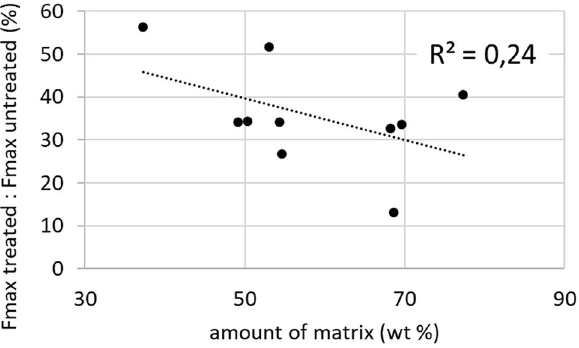
Figure 4. Ratio of tensile force at break of treated yarns and their untreated references over the average amount of isocyanate substance for each